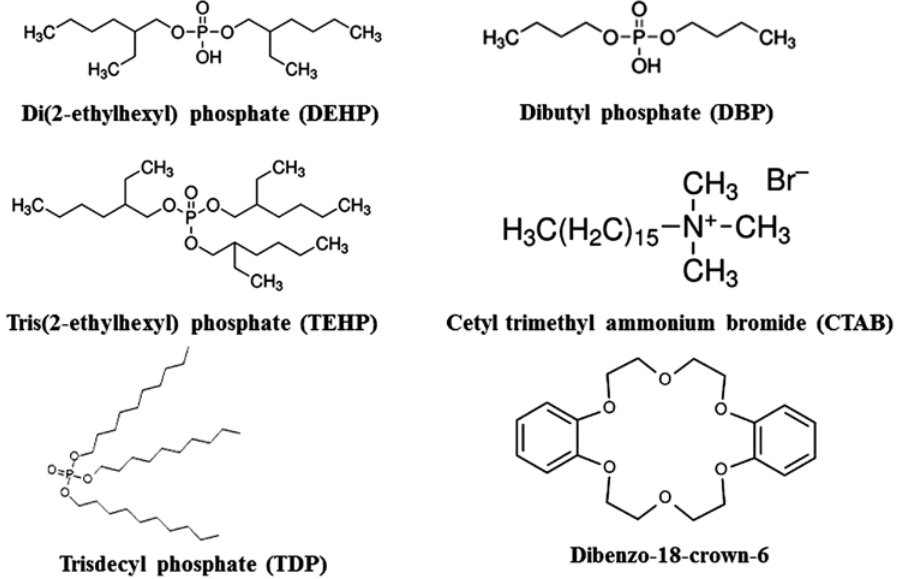
Figure 4: Structures for the representatives of additives in